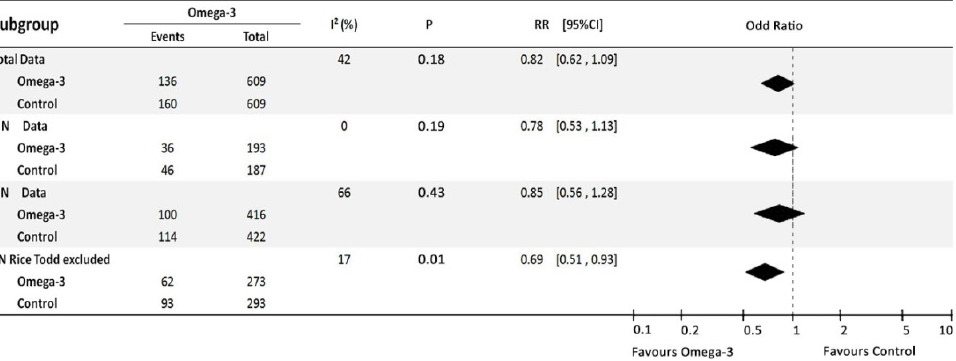
Figure 2. Effect of Omega-3 FA administration on mortality of severe patients.